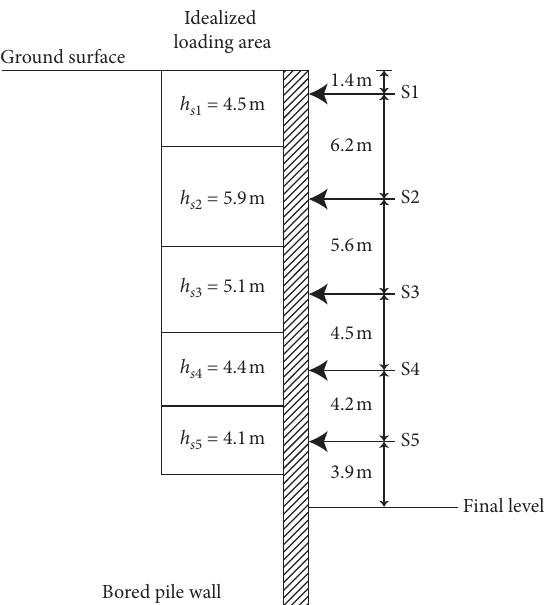
Figure 18: Cross section of idealized tributary loading areas of struts for H e � 25 . 8 m.